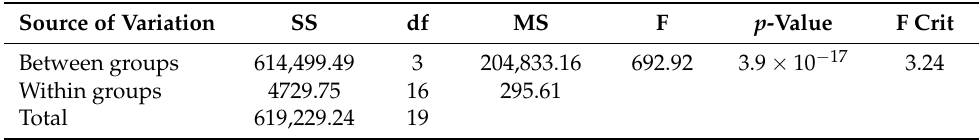
Table 9. Resulting ANOVA table for glass laminates under testing temperatures of 25–100 ◦ C.